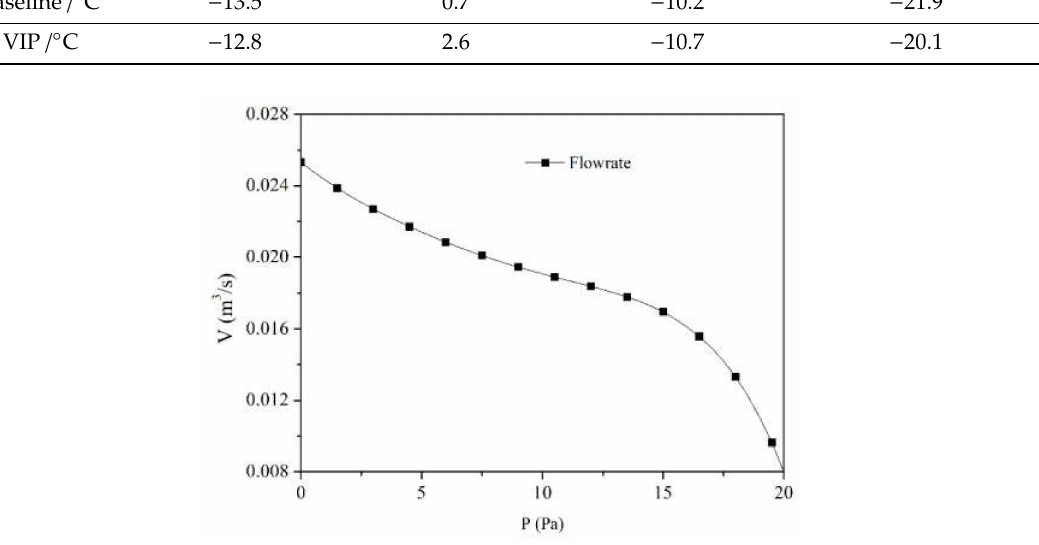
Figure 7. Characteristic curve for the axial fan of the